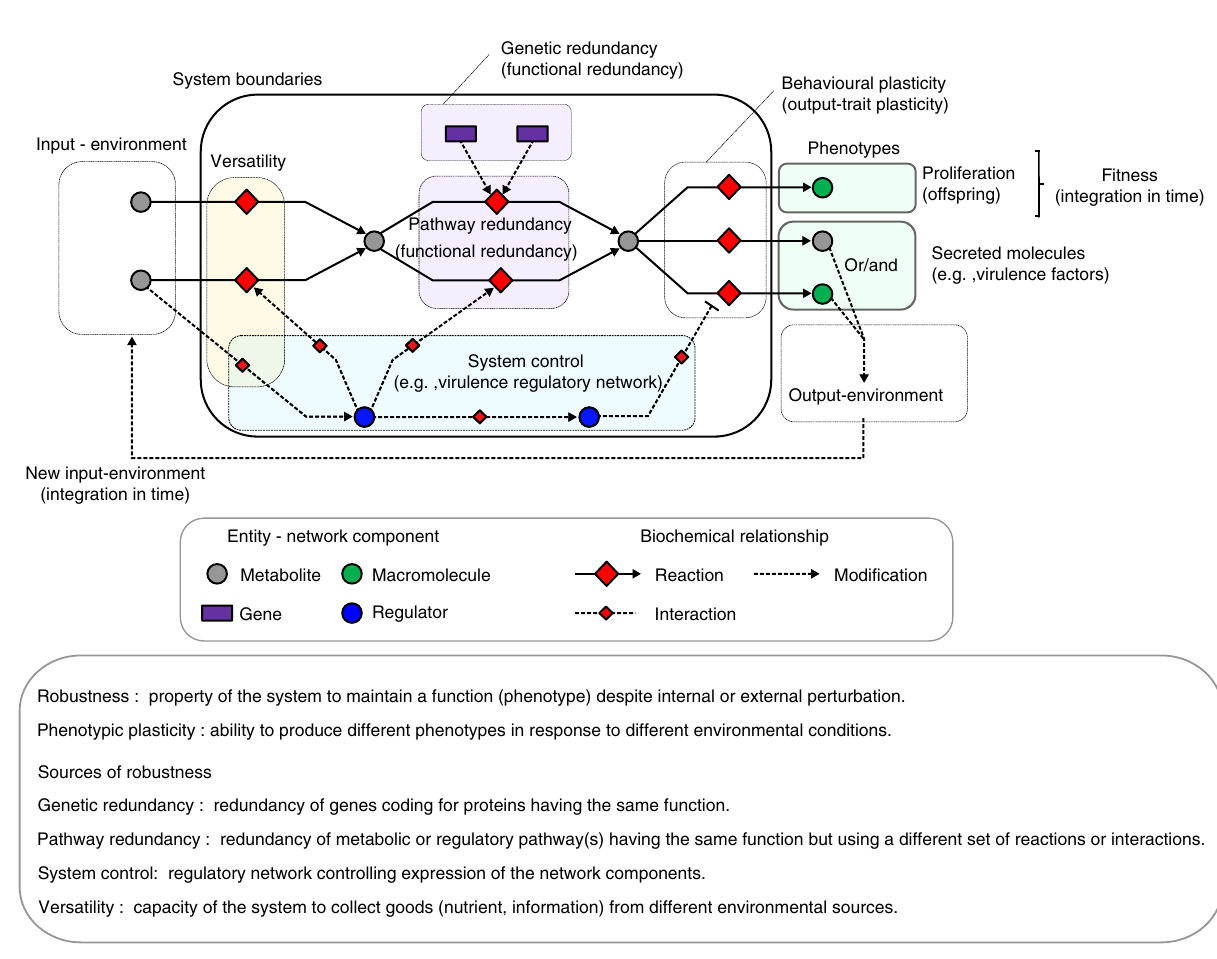
Fig. 1 Sources of robustness in biological systems. The three main sources of phenotypic robustness in biological systems with respect to internal or environmental perturbations are: versatility, functional redundancy (genetic and pathway redundancy), and the system control. The virulence functions (virulence phenotypes) can be seen as a mechanism to modify the host environment to make it bene fi cial for the growth of the